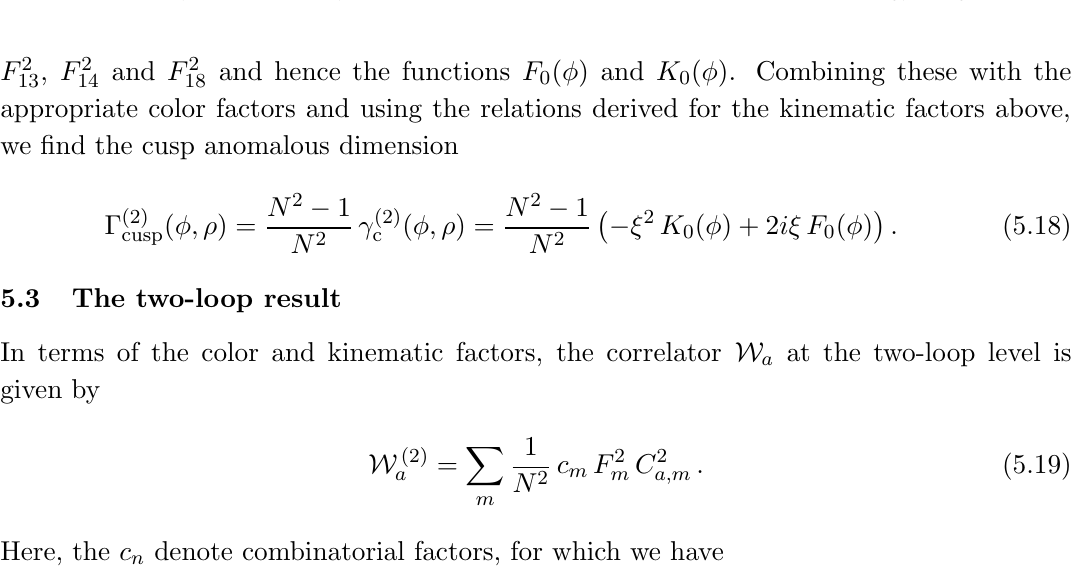
Figure 8 . Symbolic display of the relations for the three-vertex and self-energy